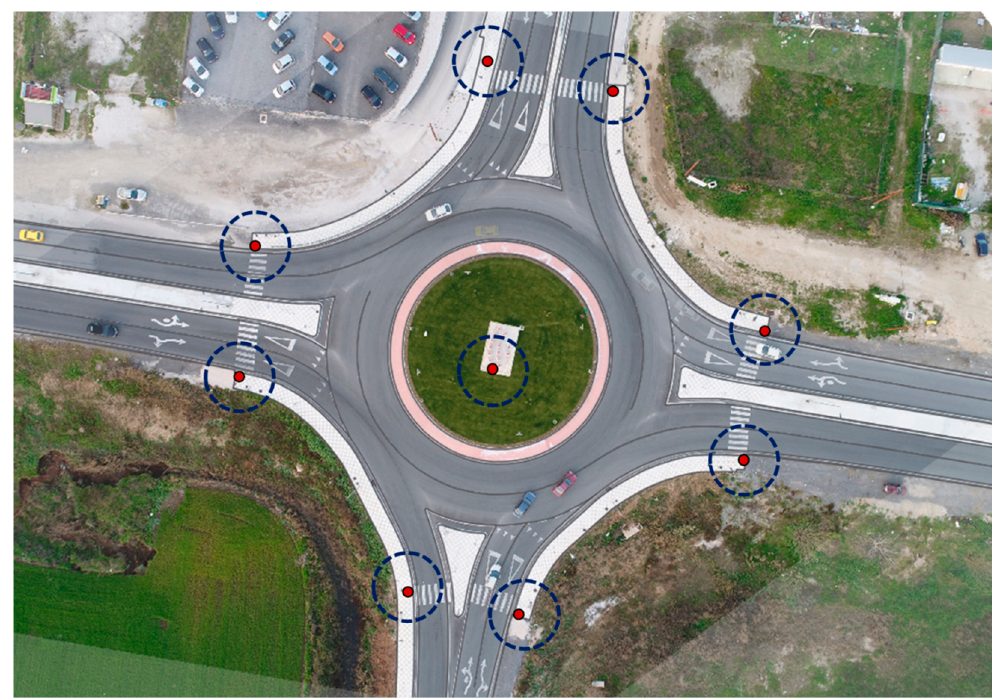
Figure 3. The location of GCPs as distributed homogeneously for the survey.